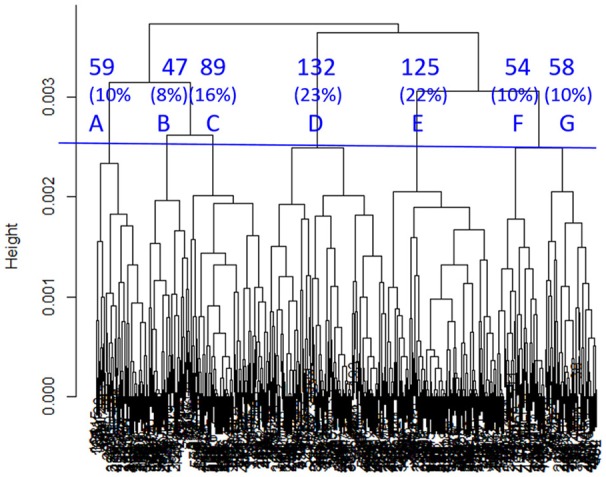
Dendrogram built by SHC. Seven clusters (A–G) were used in subsequent analyses. The percentages refer to the proportion of COBRIT patients in each cluster.